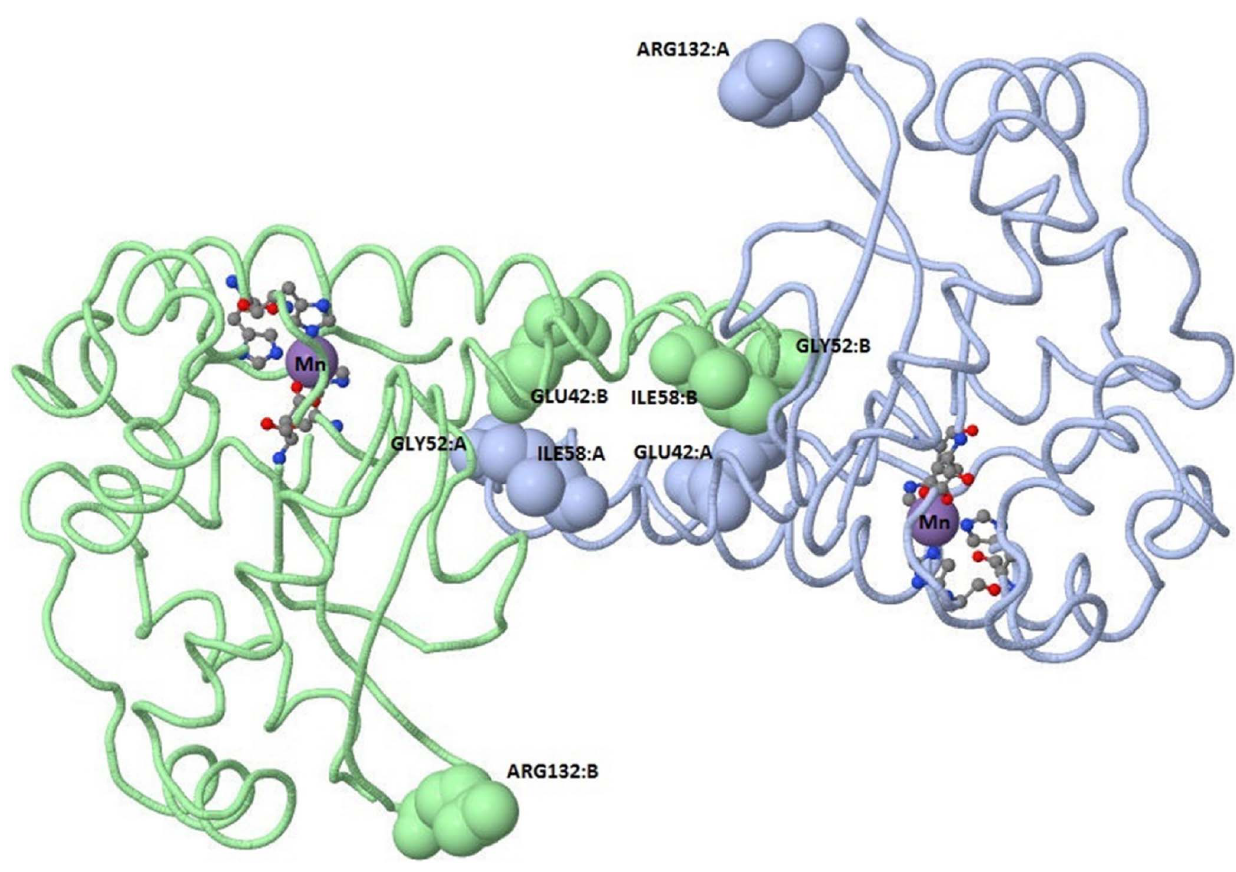
Figure 2. 3D structure of human SOD2 with four missense mutation sites. Two subunits are represented as a backbone in green and blue. Four mutation sites are shown in a sphere representation: E66V, G76R, I82T and R156. The manganese binding site is shown in ball-stick form.